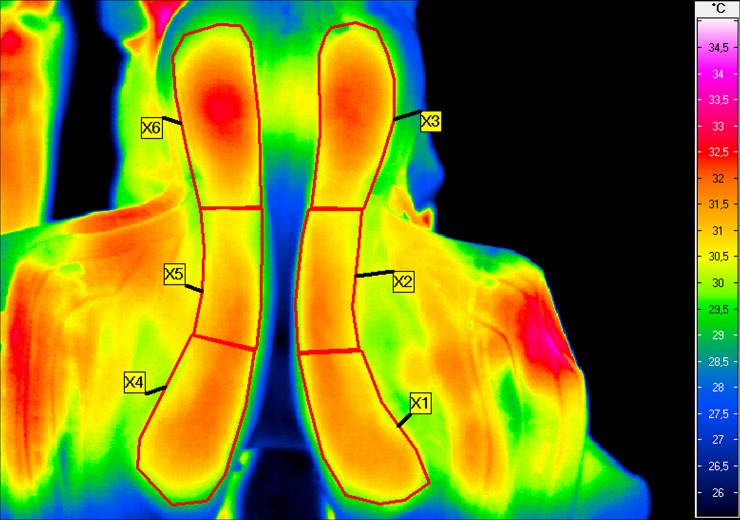
Thermographic image of saddle panels.Thermographic image of saddle panels taken immediately after untacking the horse, with the six regions of interest (ROIs) indicated: right front of the saddle (X1), right middle of the saddle (X2), right back of the saddle (X3), left front of the saddle (X4), left middle of the saddle (X5), left back of the saddle (X6).